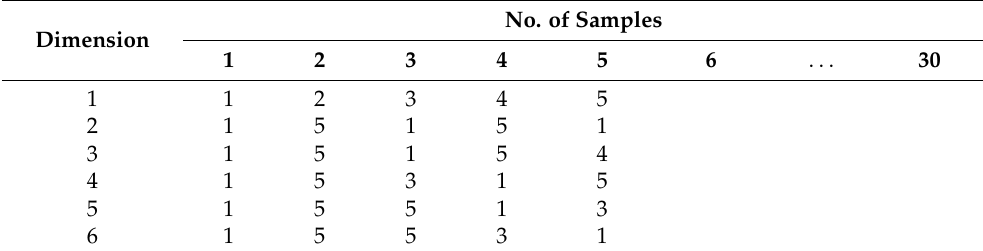
Table 2. The design matrix of position for k = 5 and L = 6.